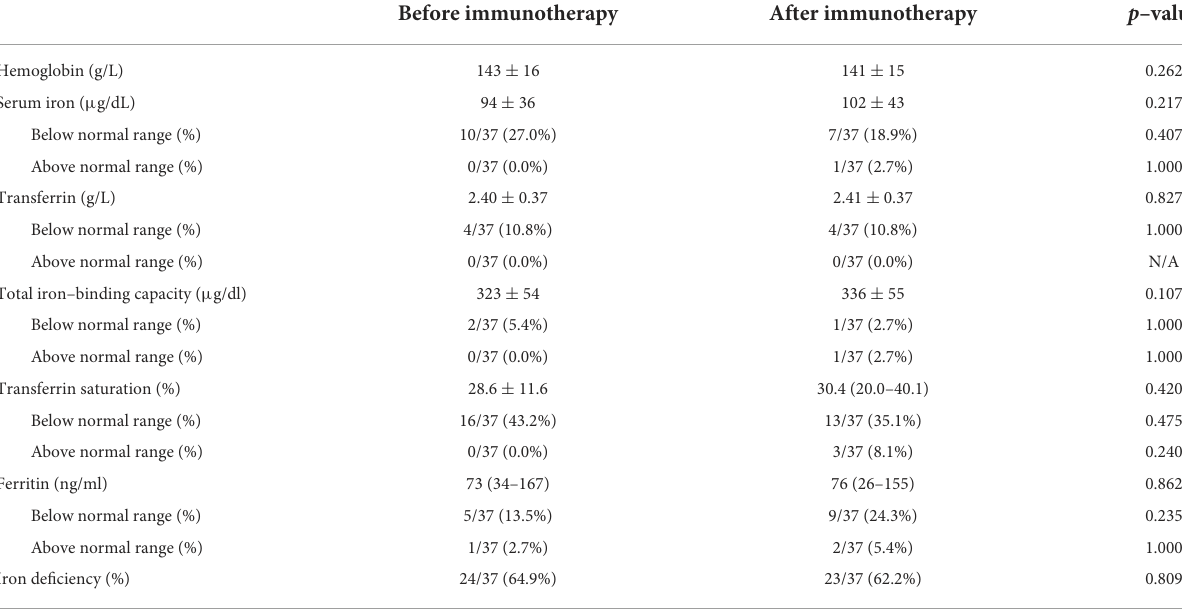
TABLE 4 Iron metabolism parameters of patients with MG before and after initiation of immunotherapy. Before immunotherapy After